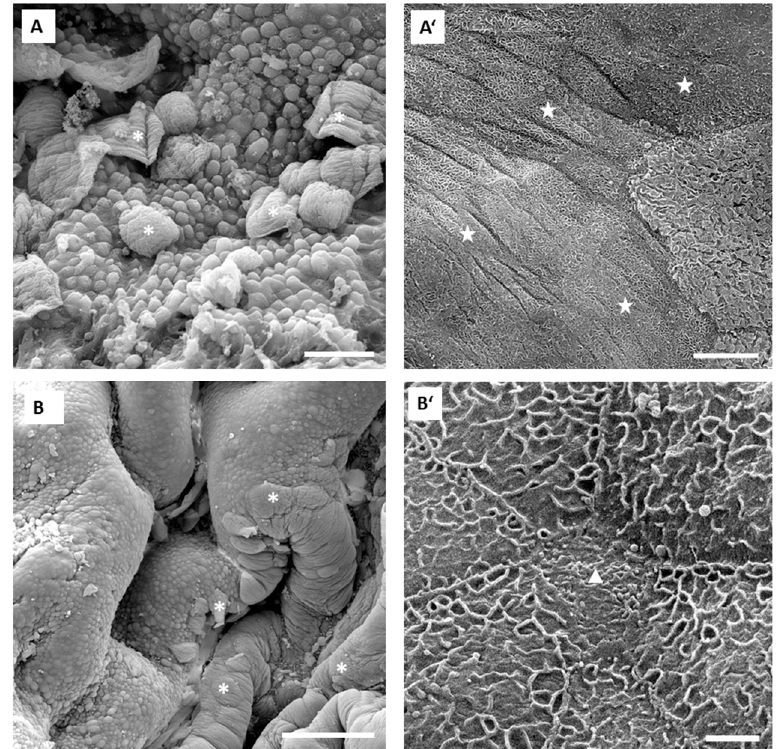
Figure 8. Representative SEM micrographs of the urothelium in in vivo experiments after 15 min exposure to 0.01% PLL with molecular weight 30–70 kDa ( A and A’ ) and 70–150 kDa ( B and B’ ). Images A’ and B’ show key features of the urothelium at higher magnifications. In images A and B are seen large and predominant areas of the urothelium, where umbrella cells desquamated and, thus, intermediate cells are exposed on the surface. Some still attached umbrella cells, which did not undergo desquamation, are present on urothelial surface (white asterisks). In desquamated urothelial areas in images A’ and B’ , exposed intermediate cells as new superficial cells are small and with microvilli (white triangle in B’ ) or ropy ridges of apical plasma membrane (white stars in A’ ). Scale bars: 50 µm ( A ), 200 µm ( B ), 20 µm ( A’ ), and 2 µm ( B’ ).